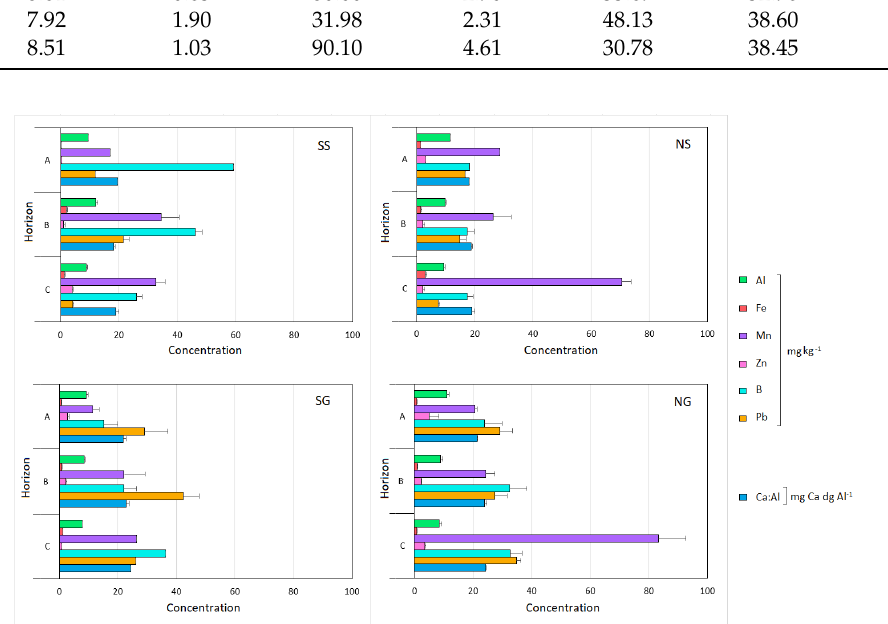
Figure 2. Mean concentration ± standard error of the minor soil elements summarised for the different master horizons (A, B, and C) of the analysed soil profiles (SS, NS, SG, and NG).